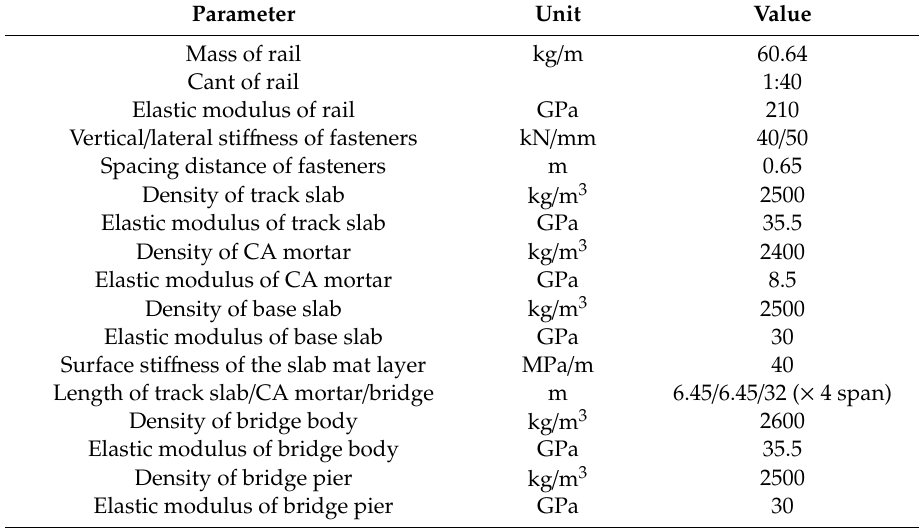
Table 2. The track–bridge model